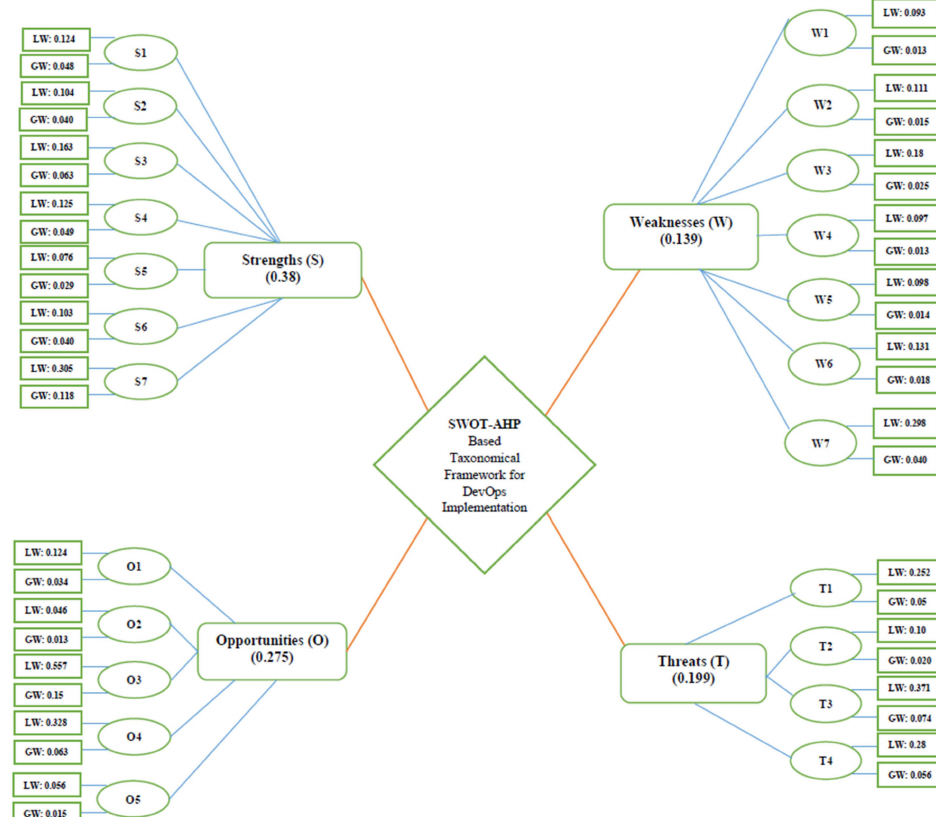
Figure 8. Taxonomy-based framework of the identified factors and their SWOT